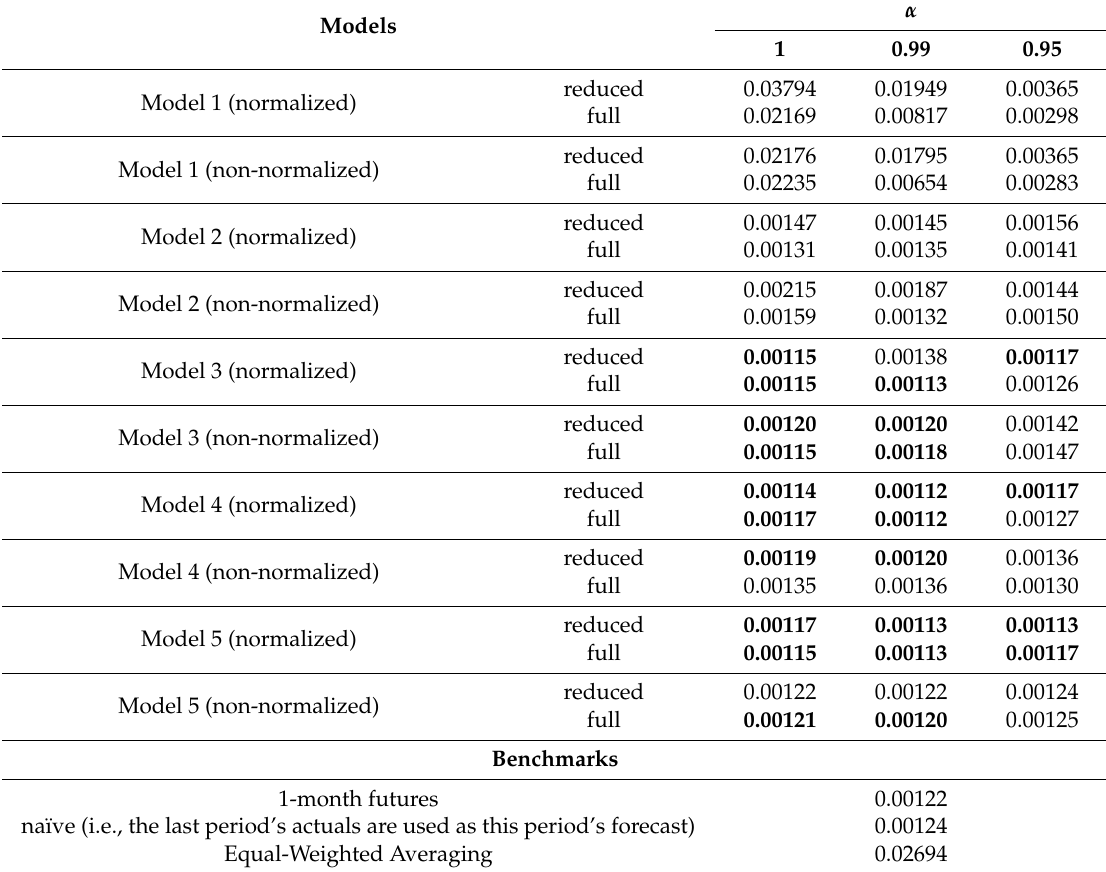
Table 4. MSE for estimated